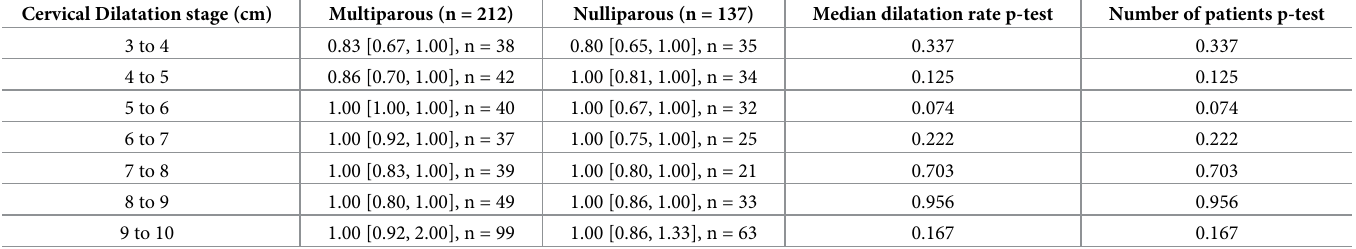
Table 2. Number of patients (n) analyzed and the median dilatation rate from one cervical dilatation stage to the next for primiparous and multiparous females. Results are expressed as median (IQR). Cervical Dilatation stage